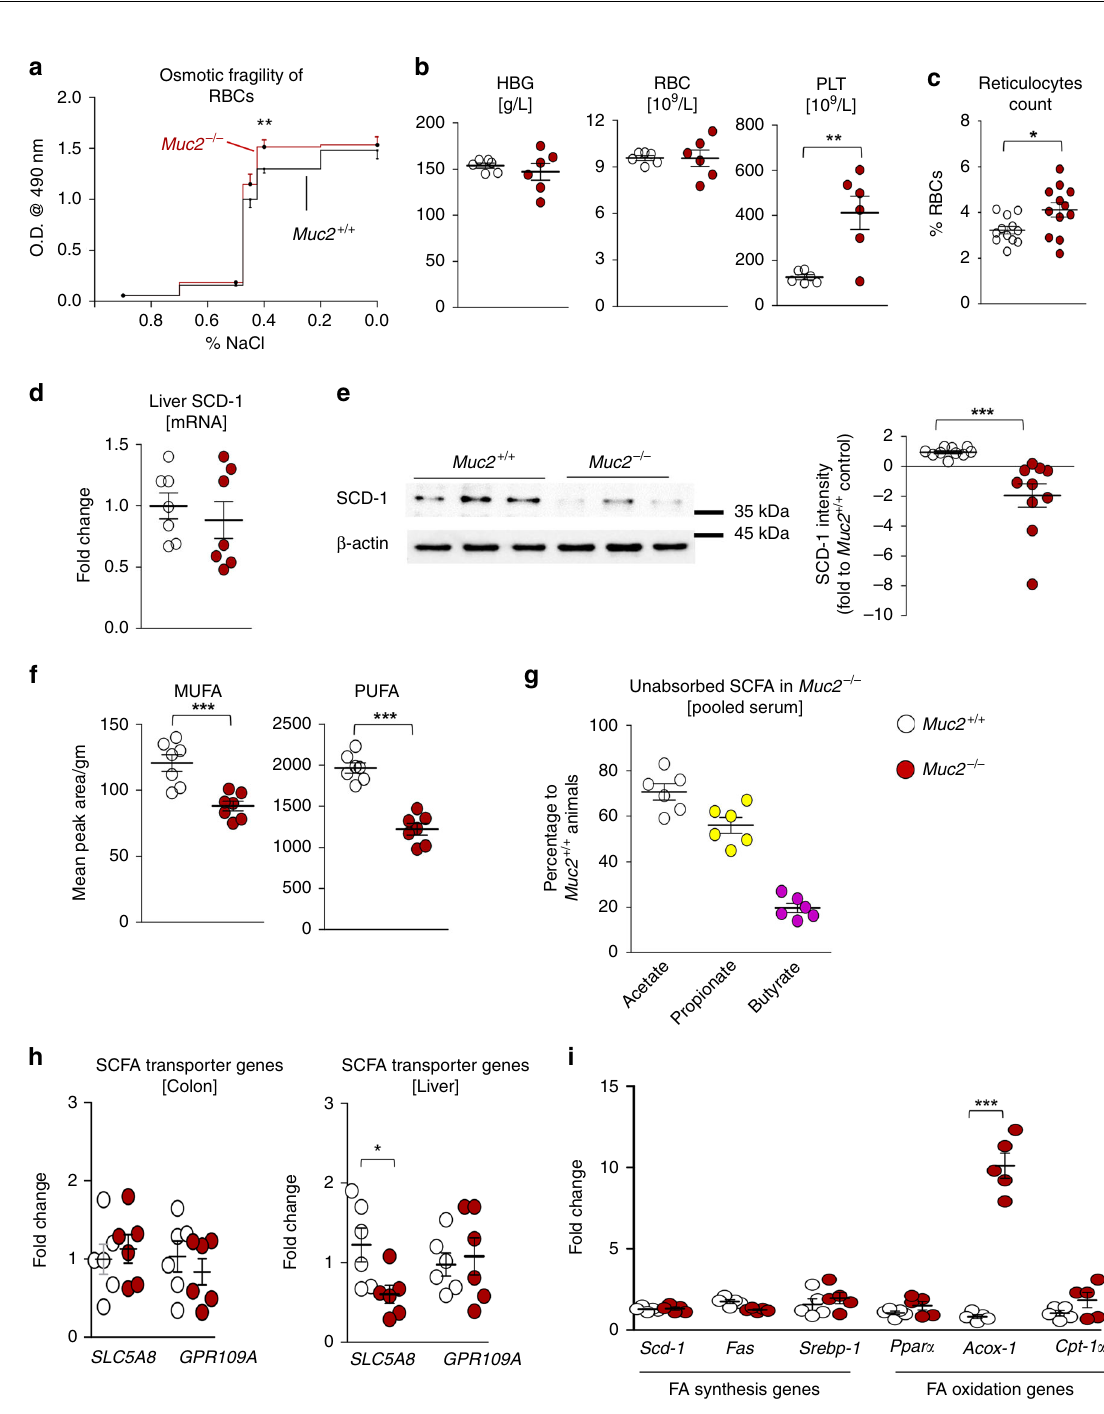
post-transfer. Muc2 + / + RBCs remained in the circulation (Fig. 6d, brighter arteries indicated with arrow) whereas Muc2 − / − RBCs were scattered throughout the spleen supporting the FACS data where Muc2 − / − RBCs left the circulation faster. Next, we injected fl uorochrome-labeled anti-mouse F4/80 antibodies to visualize erythrophagocytosis ef fi ciency and found less ery- throphagocytosis events in Muc2 − / − (Fig. 6d). Strikingly, senes- cent RBCs that were not cleared/recycled by splenic macrophages were found clustered together and formed aggregates in the spleen of Muc2 − / − littermates (Fig. 6e). To establish if basal in fl ammation in Muc2 − / − impaired erythrocyte recycling ef fi - ciency, PKH26-labeled Muc2 + / + RBCs were injected